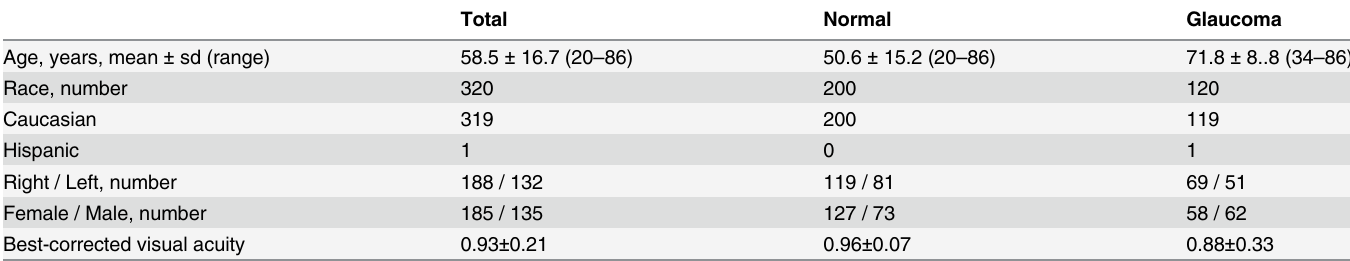
Table 2. Characteristics of the study